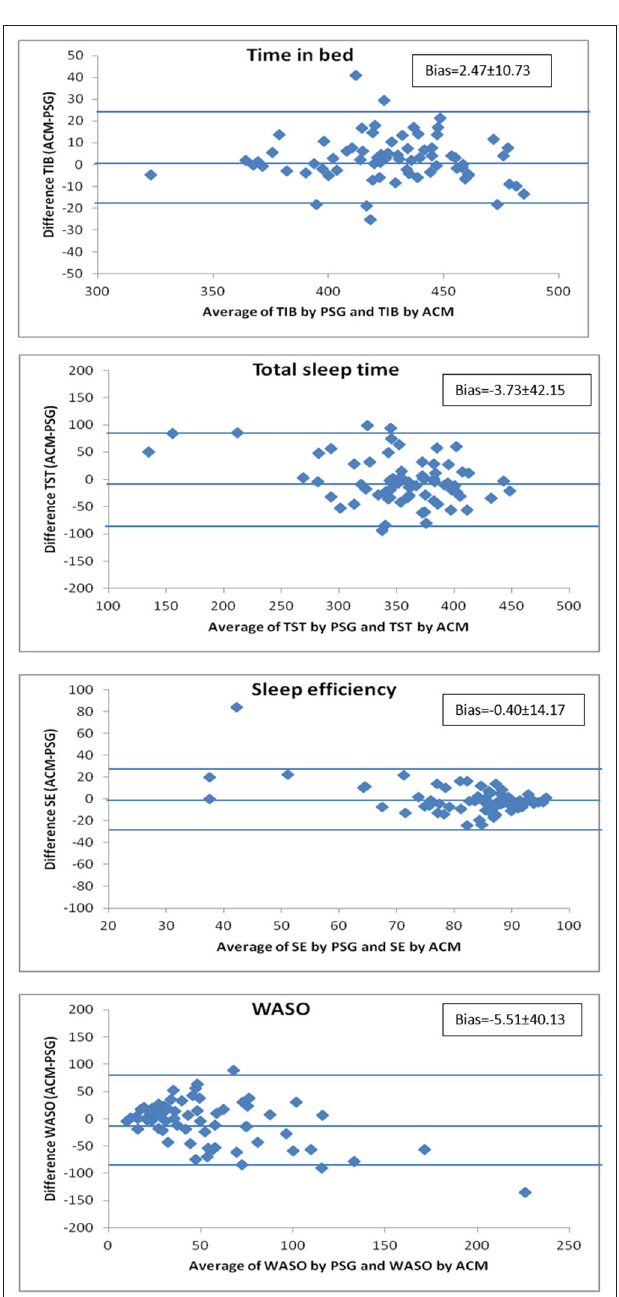
FIGURE 5 | Bland-Altman representation, comparing the deviations in the estimates generated by ACM and PSG. ACM overestimates time in bed by 0.58% and underestimates total sleep time by 1.05%, sleep efficiency by 0.48%, and WASO (wake time after sleep onset) by 10.5%. Each of the graphs shows with horizontal lines the mean deviation ± 1.96